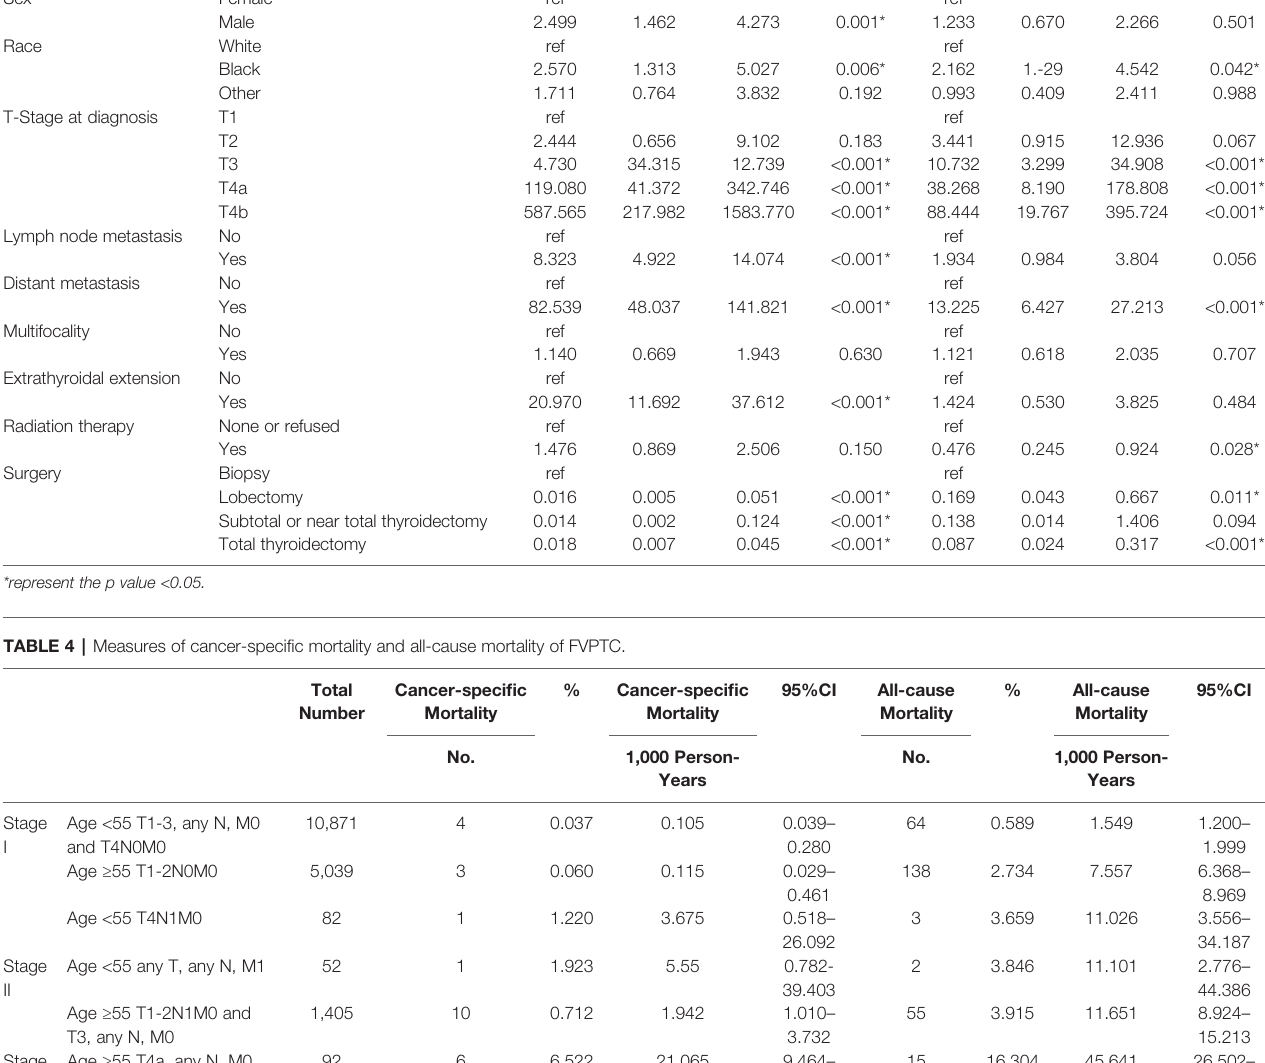
TABLE 3 | Clinicopathological parameters associated with the cancer-speci fi c survival. Parameters